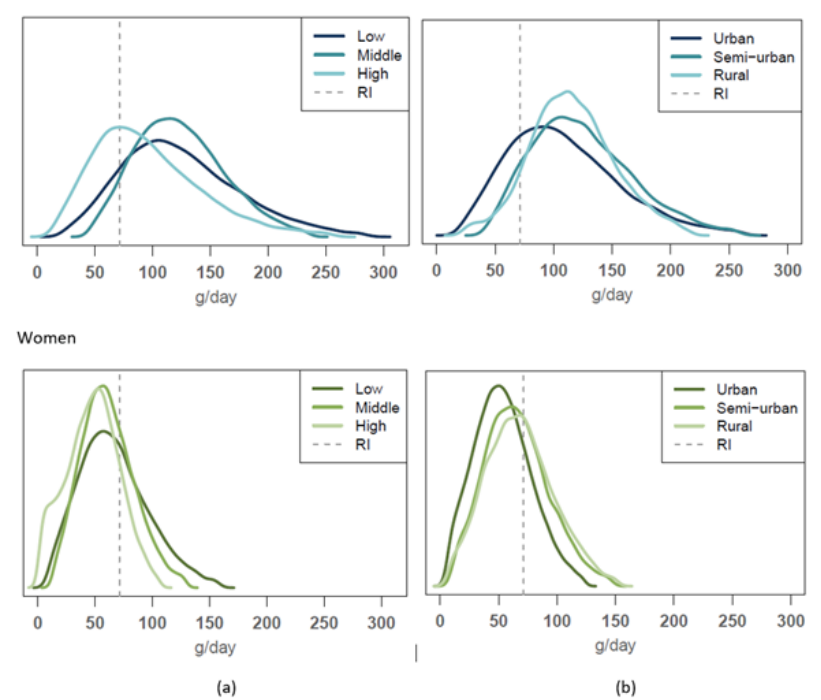
Figure 2. Usual intake distribution of red and processed meat consumption compared to the dietary guideline (RI; marked as dashed line) of a maximum of 500 g/week (= 71 g/day as cooked meat) among men (upper figures) and women (lower figures) according to ( a ) educational group and ( b ) urbanisation level.